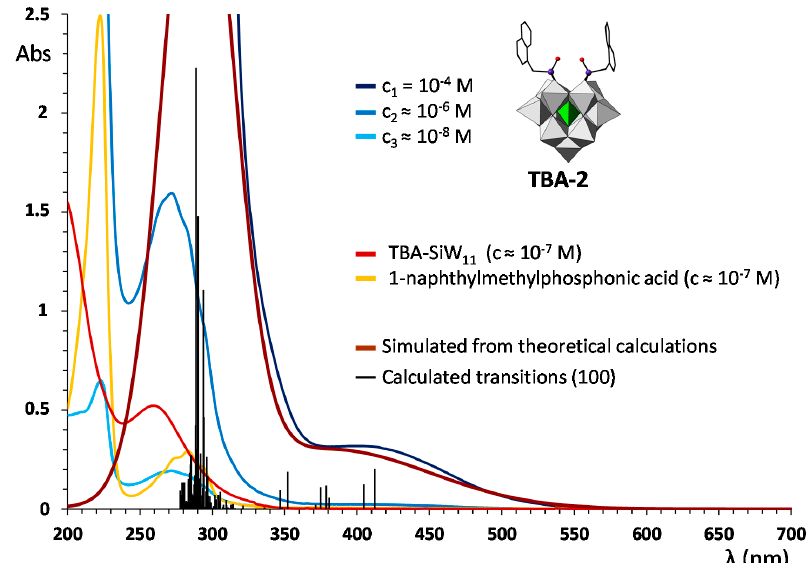
Figure 4. UV–Vis spectra of acetonitrile solutions of TBA-2 with different concentrations compared with those of the commercial 1-naphthylmethylphosphonic acid and the TBA 8 [SiW 11 O 39 ] precursor. The simulated spectrum from theoretical TD-DFT calculations and the first 100 transitions with calculated relative intensity are also depicted.